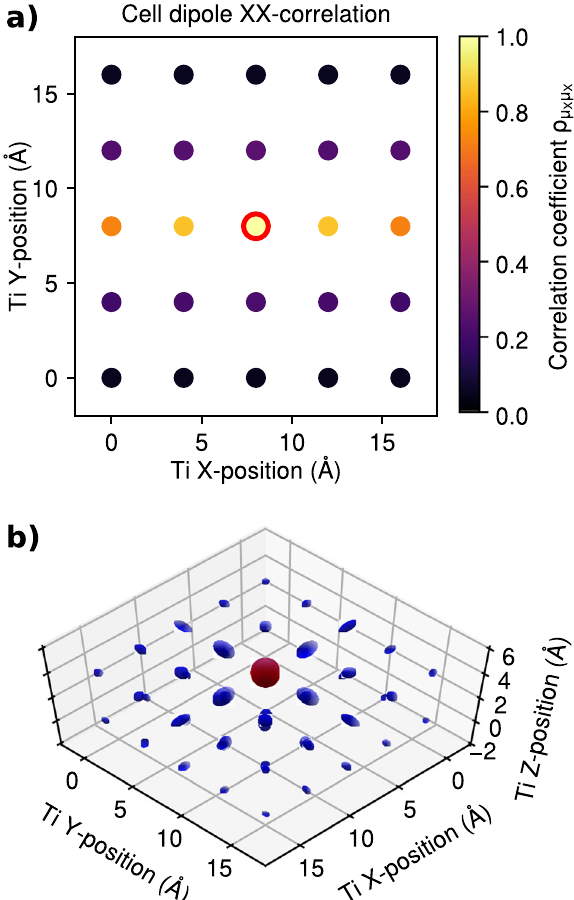
Fig. 2 Spatial correlations of the unit-cell dipoles computed on a 5 × 5 × 5 supercell simulated at 250 K. a Slice at constant Z of the correlation of the X-component of the dipole of the unit-cell centered on one Ti-atom (circled in red) with the X-component of the dipole of every other Ti-centered cell. b 3D view of the dipole correlations for the lower half of the same 5 × 5 × 5 supercell; the full 3 × 3 correlation tensor of each dipole with the central Ti-atom (red sphere) is shown as an ellipsoid, where the elongation along the Cartesian axes shows the presence of highly directional, needle-like correlations 91